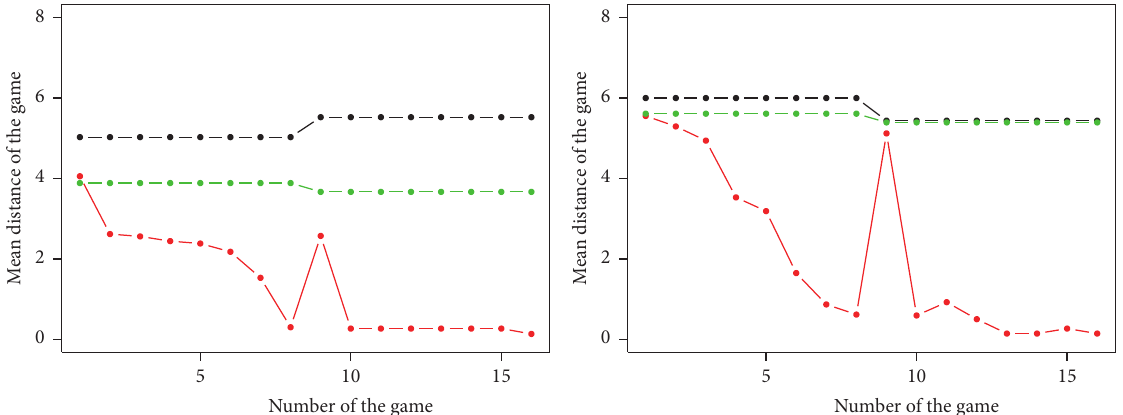
Figure 5: Average distance for each game. Each figure represents a different run of the experiment. The green line represents an AI with no machine learning and which used a uniformly distributed transition matrix. The black line represents the same AI but this time one that used a transition matrix built using game experience, as Hladky and Bulitko did. Finally, the red line was obtained by playing against our AI with adaptive